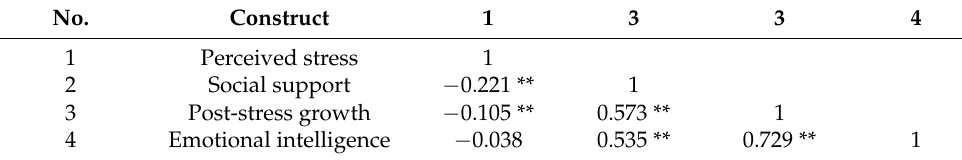
Table 2. Descriptive statistics and correlation among variables.